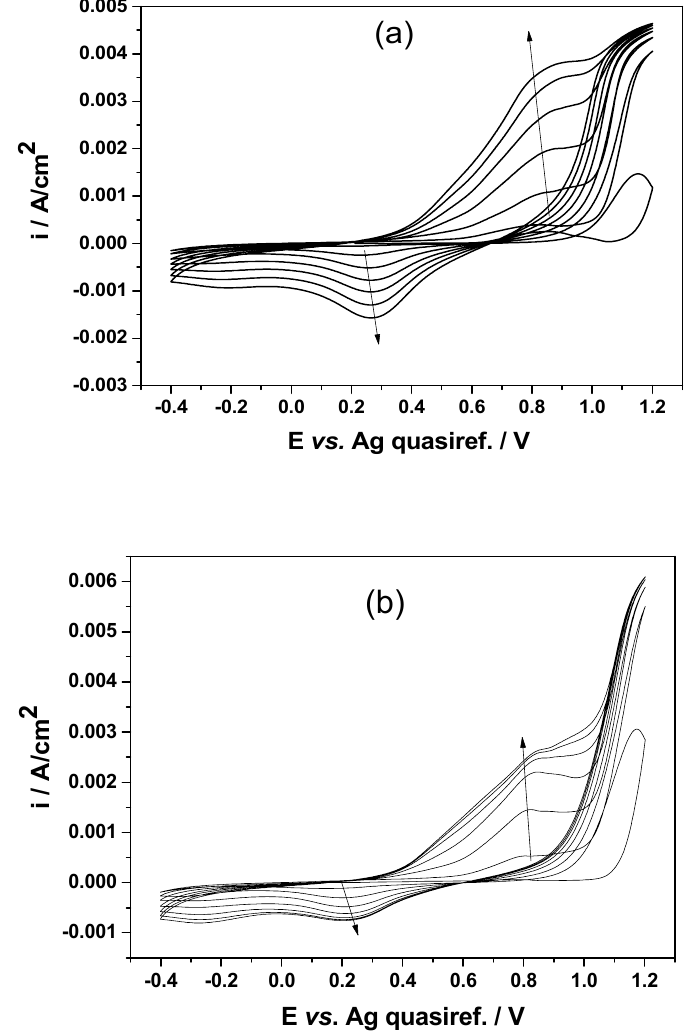
Figure 2. Cyclic voltammograms on IB ( a ) and ND ( b ) NiCr alloys during electrosynthesis of PPy from ILM-ACN electrolyte containing 0.5 M Py. The scan rate was 10 mV s –1 and T = 25 °C.